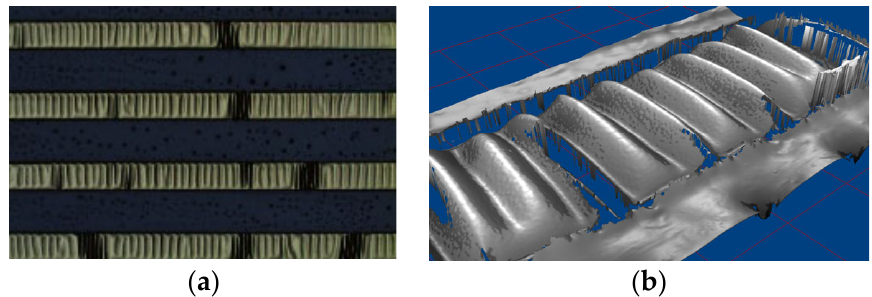
Figure 11. Wrinkling pa tt ern and 3D measurement. ( a ) Optical microscope; ( b ) 3D pro fi ler.